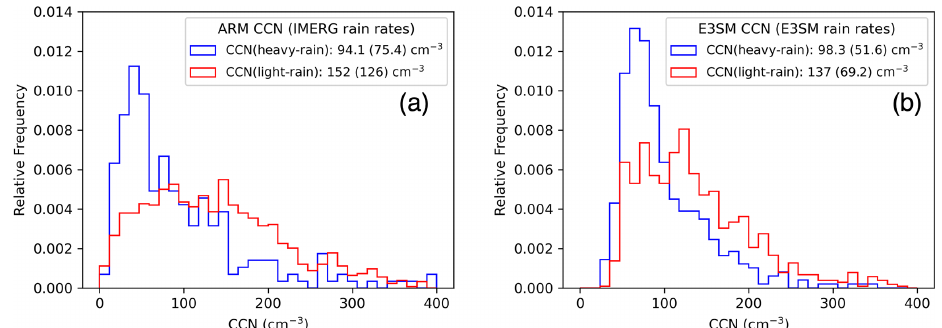
Figure 4. (a) Relative frequency values in the distribution of CCN concentration measured at 0.2% supersaturation observed by ARM at the ENA site are provided for trajectories with above (blue) and below (red) median accumulated IMERG precipitation values in the previous 48h along the back trajectories. Panel (b) shows the same distributions from the same trajectories but using E3SM CCN concentration and precipitation rates instead. Mean and standard deviation values (shown in parentheses) are provided for each